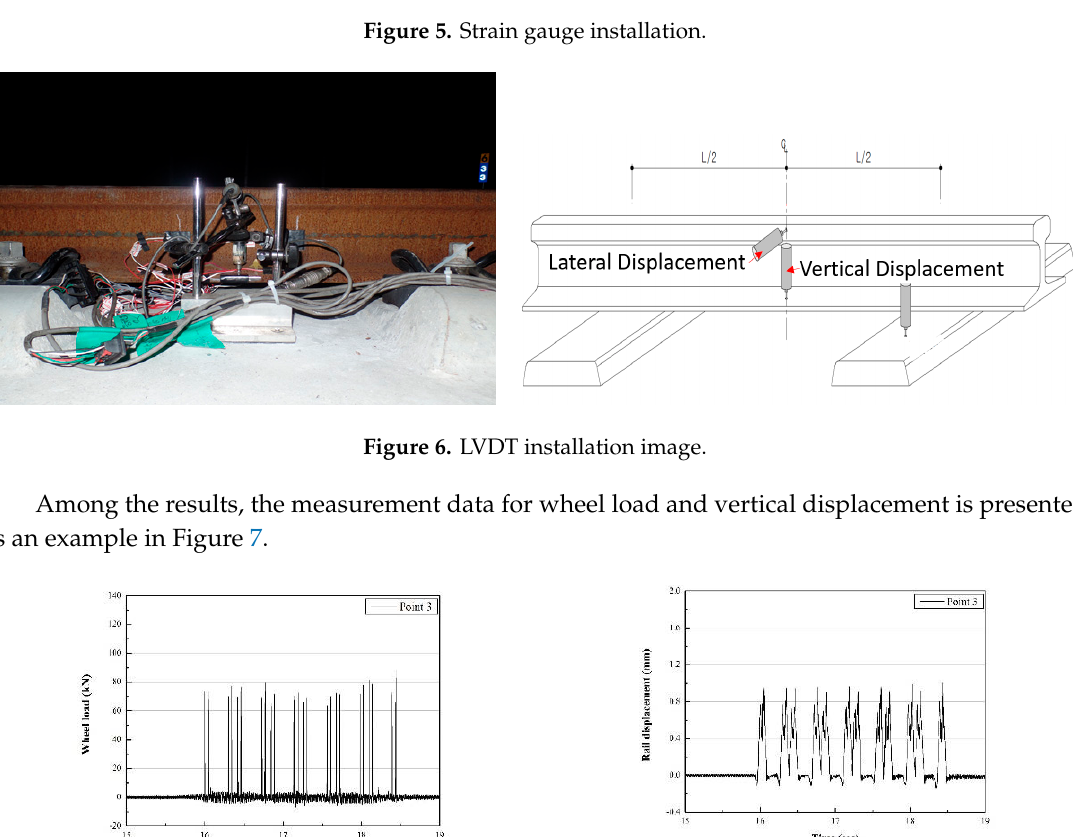
Table 6. Vehicle specification for trackside measurement.